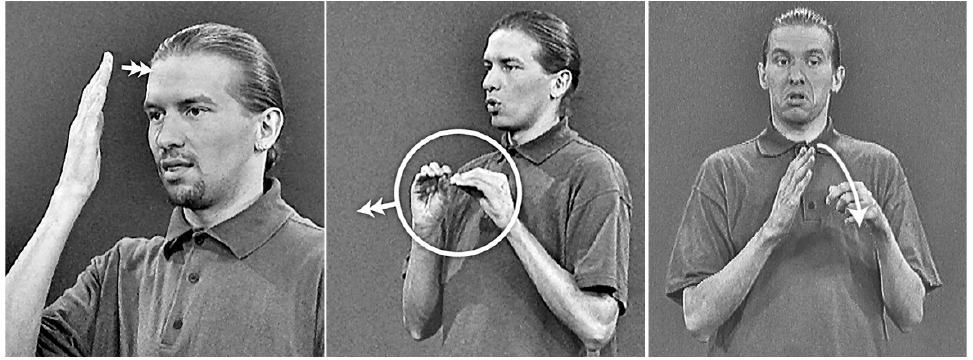
Figure 3. FinSL verbals with the meanings (from left to right) ‘know’ (the finger pads of the open hand touch the forehead twice), ‘teach [someone in front of the signer]’ (the two hands move forward twice in the shown configuration), and ‘an oblong vehicle (e.g. a bicycle) moves forward over something like a mound’ (the dominant hand articulates an arc-shaped movement over the stationary non-dominant hand). The verbals represent Type 1, Type 2, and Type 3, respectively. Images from Suoma- laisen viittomakielen perussanakirja